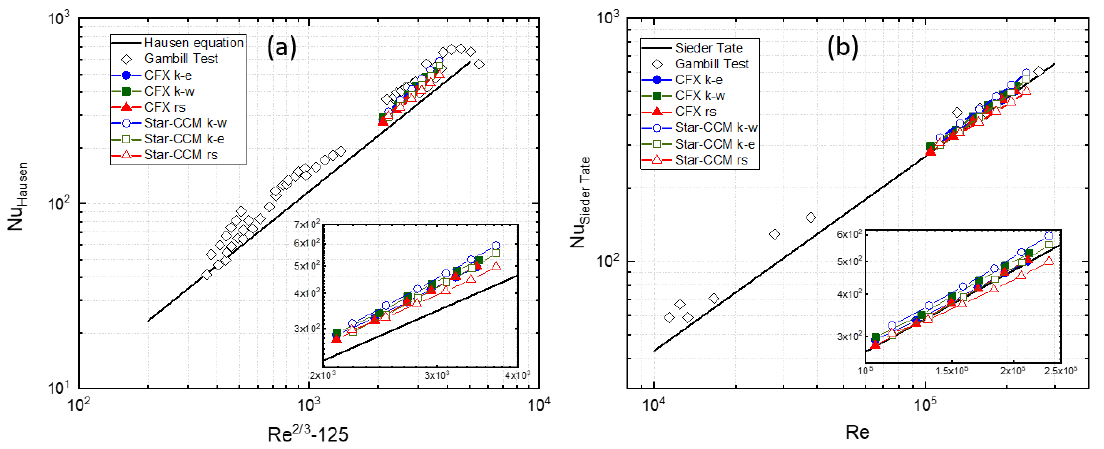
Figure 7: The results for the Hausen (a) and Sieder Tate (b) equations by using 1a in Ansys CFX and mesh 1b in STAR-CCM+ are shown. Smooth walls were